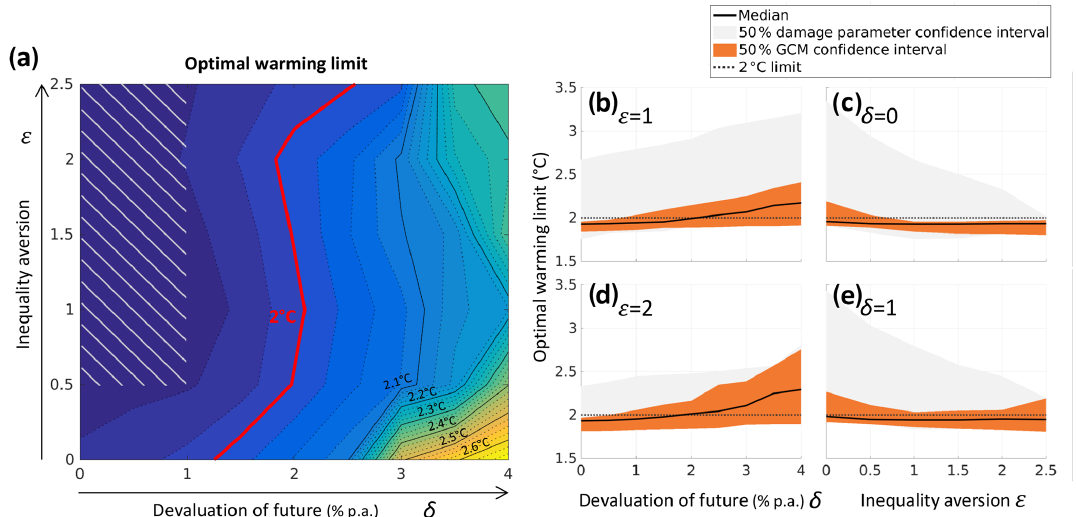
Figure 2. Optimal warming limits. Maximum global mean temperature increase above preindustrial levels in the 21st century are below 2 ◦ C for a broad range of values of the normative parameters’ pure rates of time preference δ and inequality aversion ε . (a) Optimal global warming limits from the GCM median values and median damage parameter specification from Burke et al. (2015) applied for the SSP2 scenario. The shaded area marks typical literature values for both normative parameters (Anthoff et al., 2009; IPCC, 2014a). (b–e) One-dimensional cross sections of the two-dimensional plot focused on the typical parameter range: (b) ε = 1, (c) δ = 0%yr − 1 , (d) ε = 2 and (e) δ = 1%yr − 1 , all for SSP2, indicating the median (black line), the 50% confidence interval of GCM results (grey), and damage parameter specification